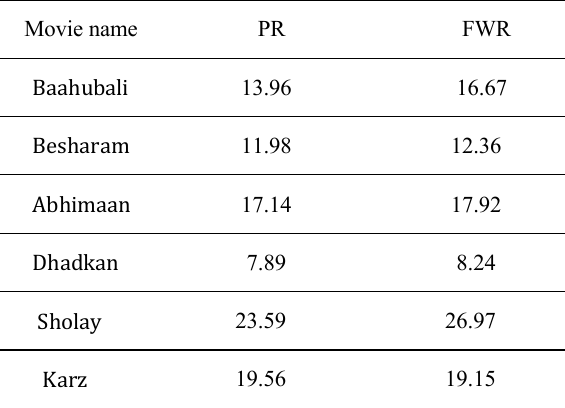
Table 7: Average number of regressions